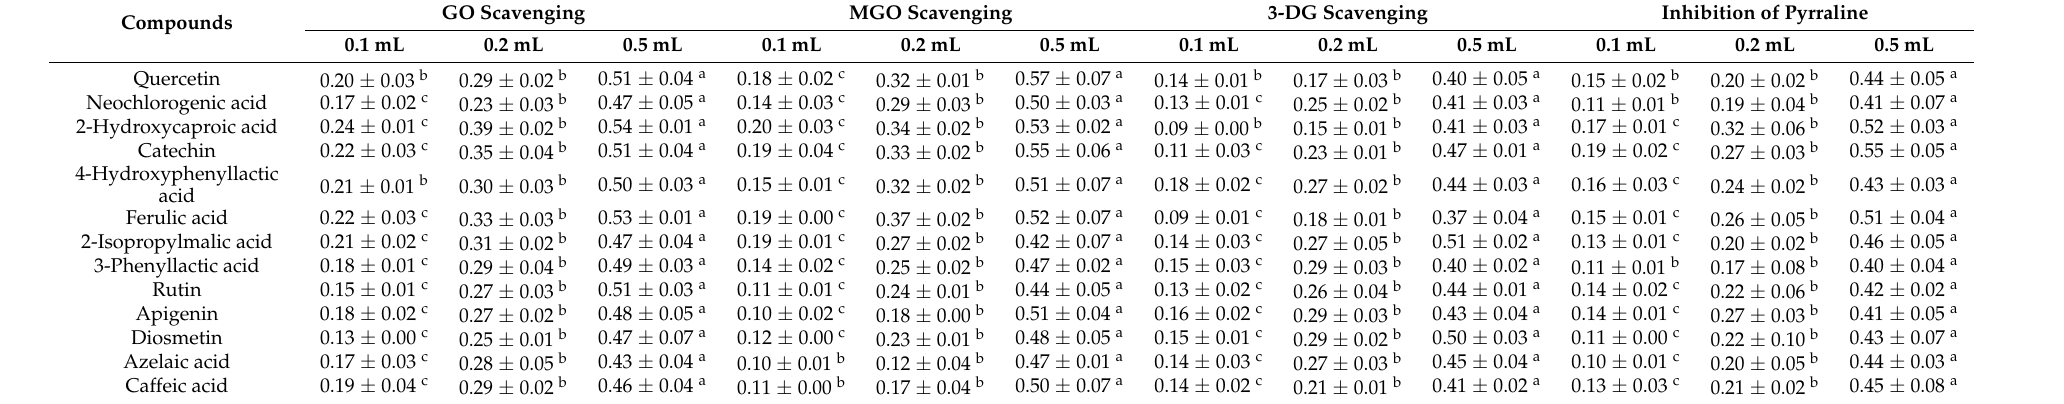
Table 3. Scavenging ability and inhibitory effect of phenolic compounds on α -dicarbonyl